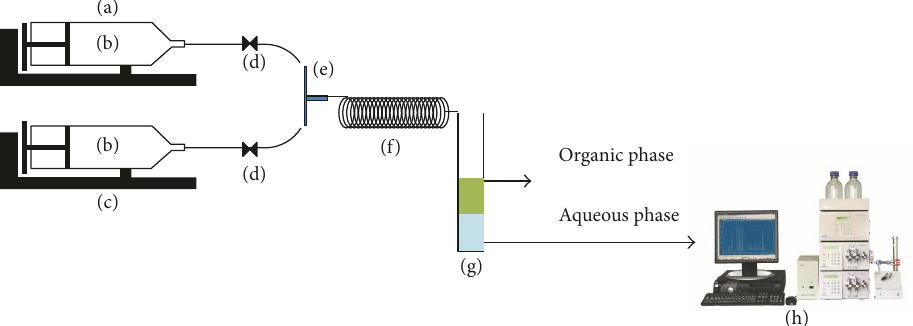
Figure 1: Microchannel system: (a) organic phase, (b) microsyringe pumps, (c) aqueous phase, (d) valve, (e) T-shaped microchannel, (f) coil, (g) extracted sample, and (h) HPLC.